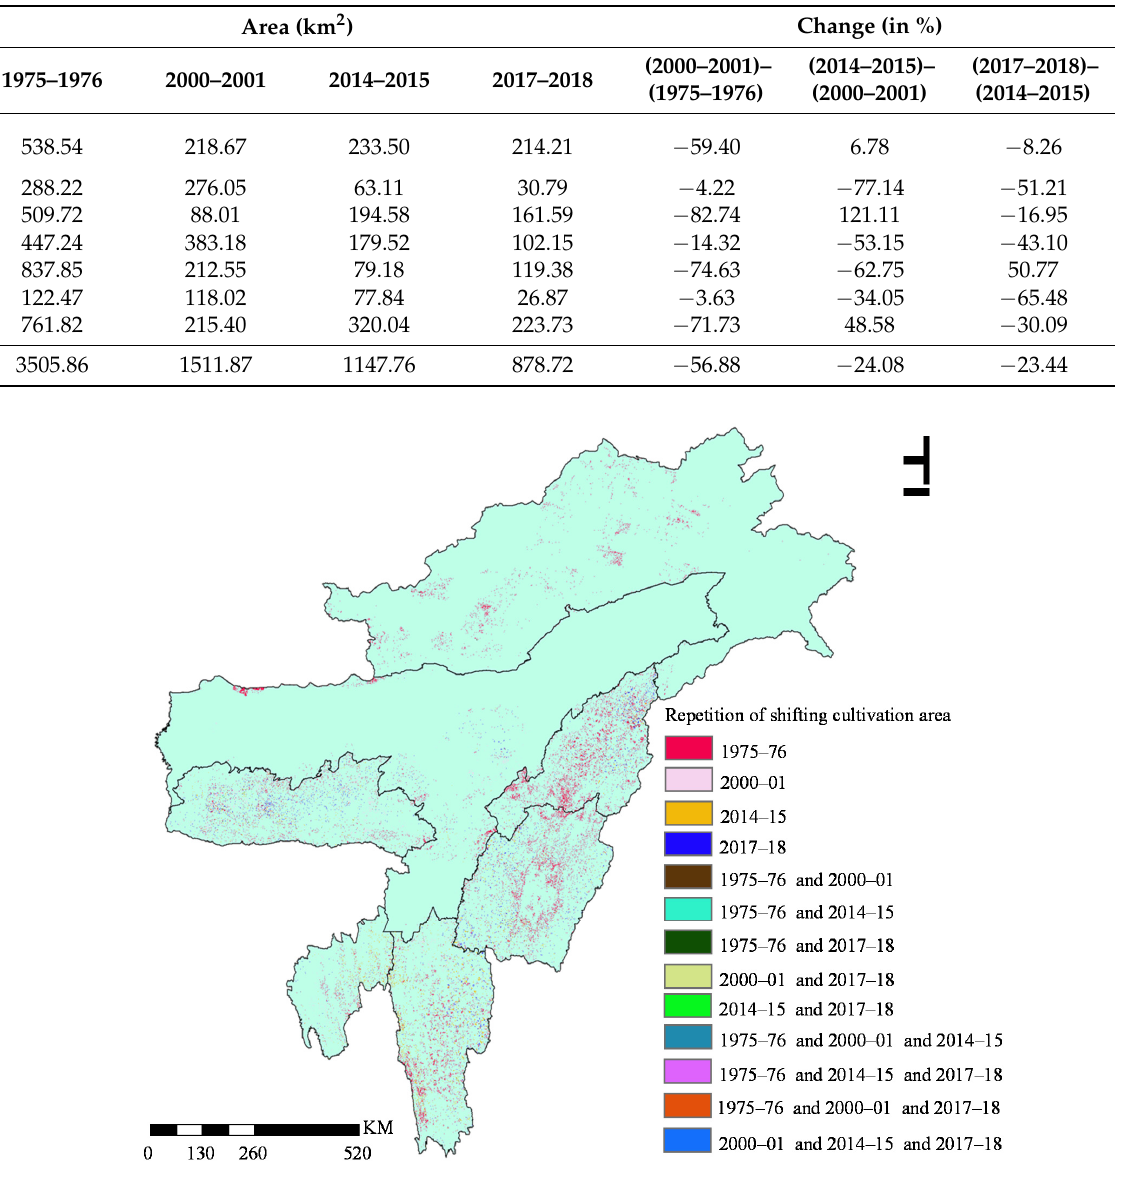
Table 2. Shifting cultivation area statistics as mapped using DTMT method from Landsat data.